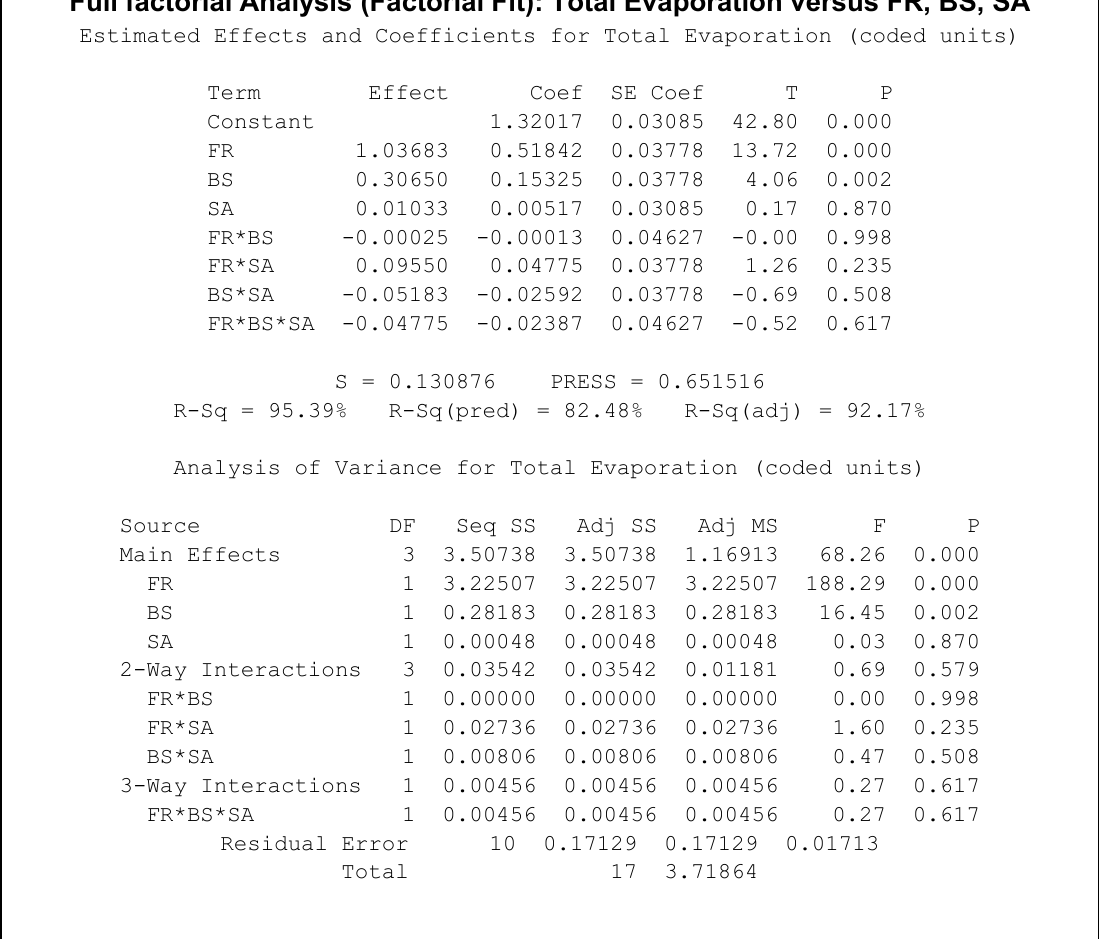
Figure 4. A full factorial analysis of total evaporation against bell speed (BS), flow rate (FR) and shaping air